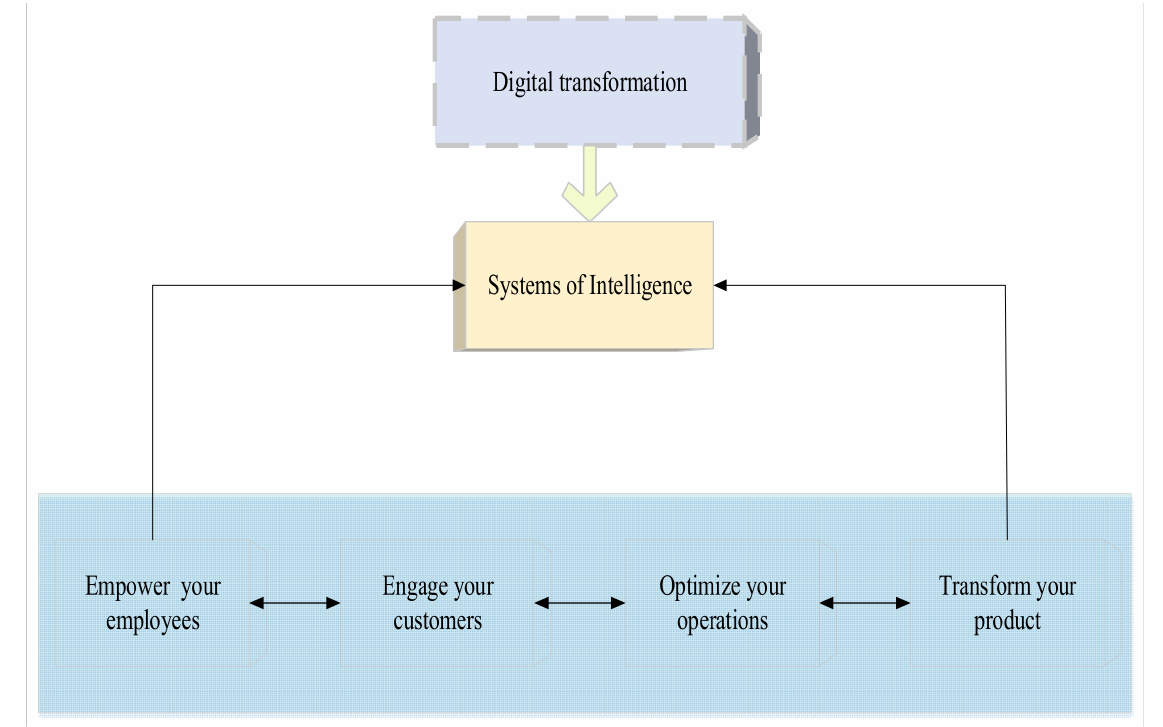
Figure 1. Value system of